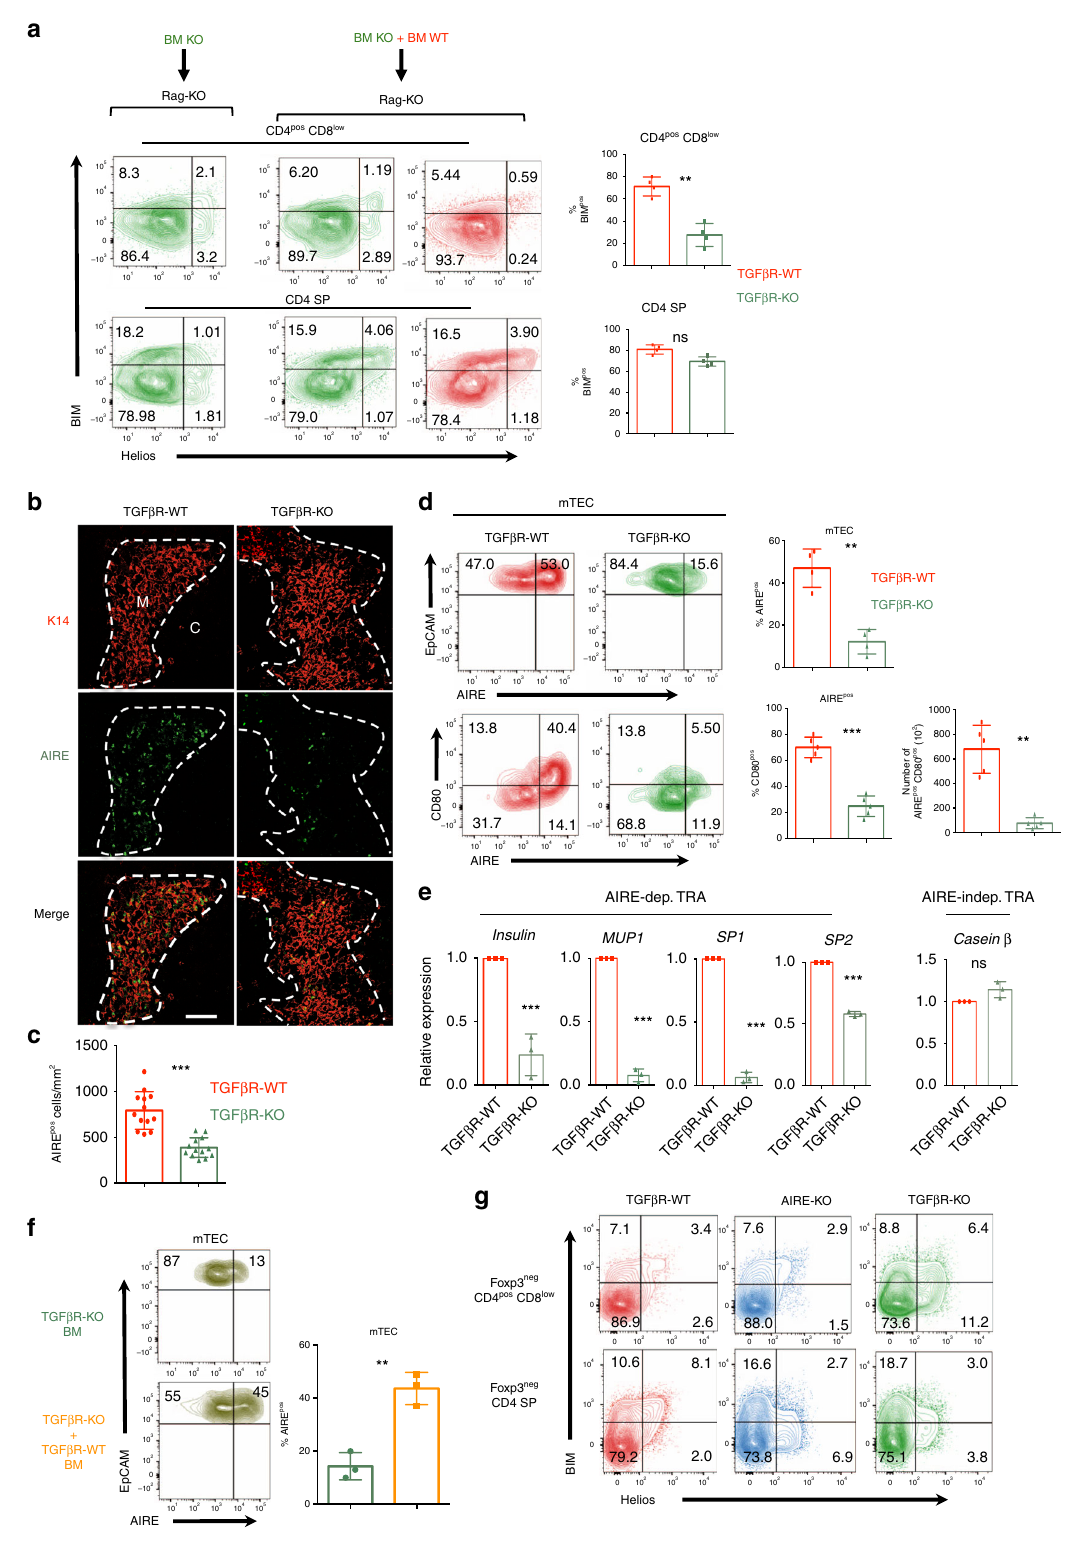
expression in Foxp3 neg PD-1 pos CD4 pos CD8 low TGF β